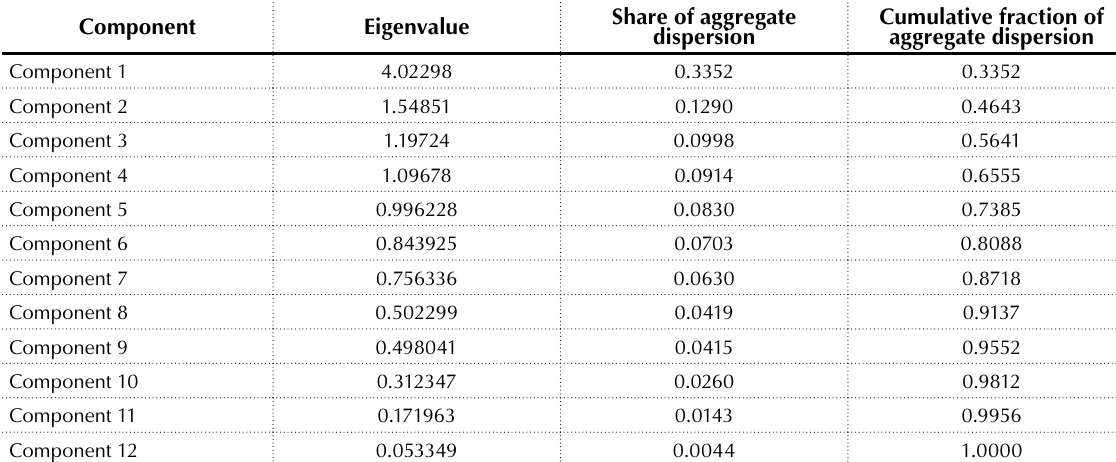
Table 2. Results of the principal components method